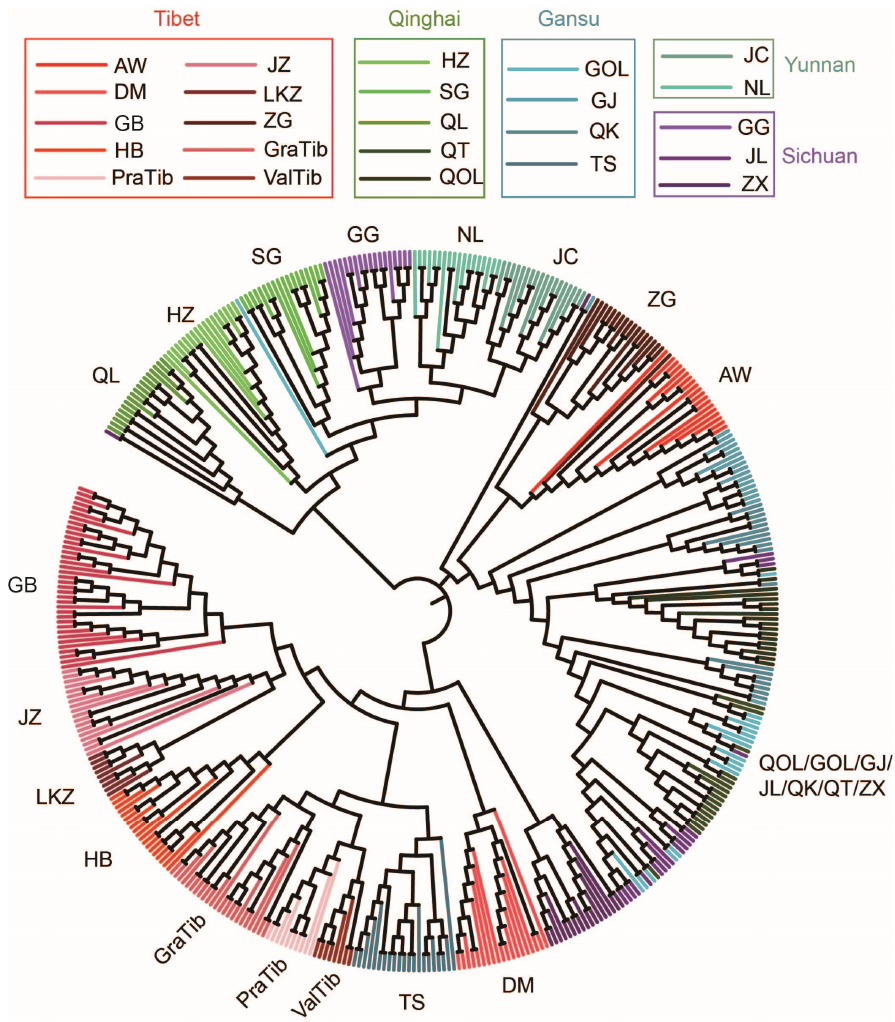
Figure 2. The NJ tree of 24 sheep breeds. The color of the symbols that indicate the geographic regions are the same as those in the PCA plots. The red color represents Tibetan sheep in Tibet (N = 180—AW, Awang sheep from Gongjue County in Tibet, 19; DM, Duoma sheep from Anduo County in Tibet, 19; GB, Gangba sheep from Gangba County in Tibet, 37; HB, Huoerba sheep from Zhongba County in Tibet, 19; JZ, Jiangzi sheep from Jiangzi County in Tibet, 18; LKZ, Langkazi sheep from Langkazi County in Tibet, 9; ZG, Zuogong sheep from Zuogong County in Tibet, 18; ValTib, Shangu sheep from Gongga County in Tibet, 8; PraTib, grassland sheep from Dangxiong County in Tibet, 10; GraTib, grassland sheep from Gaize County in Tibet, 23). The cyan color represents Tibetan sheep in Yunnan (N = 36—JC, Jianchuan sheep from Jianchuan County in Yunnan, 18; NL, Ninglang sheep from Ninglang Autonomous County in Yunnan, 18). The green color represents Tibetan sheep in Qinghai (N = 90—HZ, Heizang sheep from Guinan County in Qinghai, 18; SG, Shangu sheep from Maqin County in Qinghai, 18; QL, Qilian sheep from Qilian County in Qinghai, 18; QT, Qinghai Tibetan sheep from Zeku County in Qinghai, 18; QOL, Oula sheep from Henan County in Qinghai, 18). The blue color represents Tibetan sheep in Gansu (N = 75—GOL, Oula sheep from Maqu County in Gansu, 18; GJ, Ganjia sheep from Xiahe County in Gansu, 18; QK, Qiaoke sheep from Luqu County in Gansu, 18; TS, Tao sheep from Zhuoni County in Gansu, 21). The purple color represents Tibetan sheep in Sichuan (N = 55—GG, Gongga sheep from Luding County in Sichuan, 18; JL, Jialuo sheep from Aba County in Sichuan, 18; ZXK, Zhaxika sheep from Shiqu County in Sichuan,